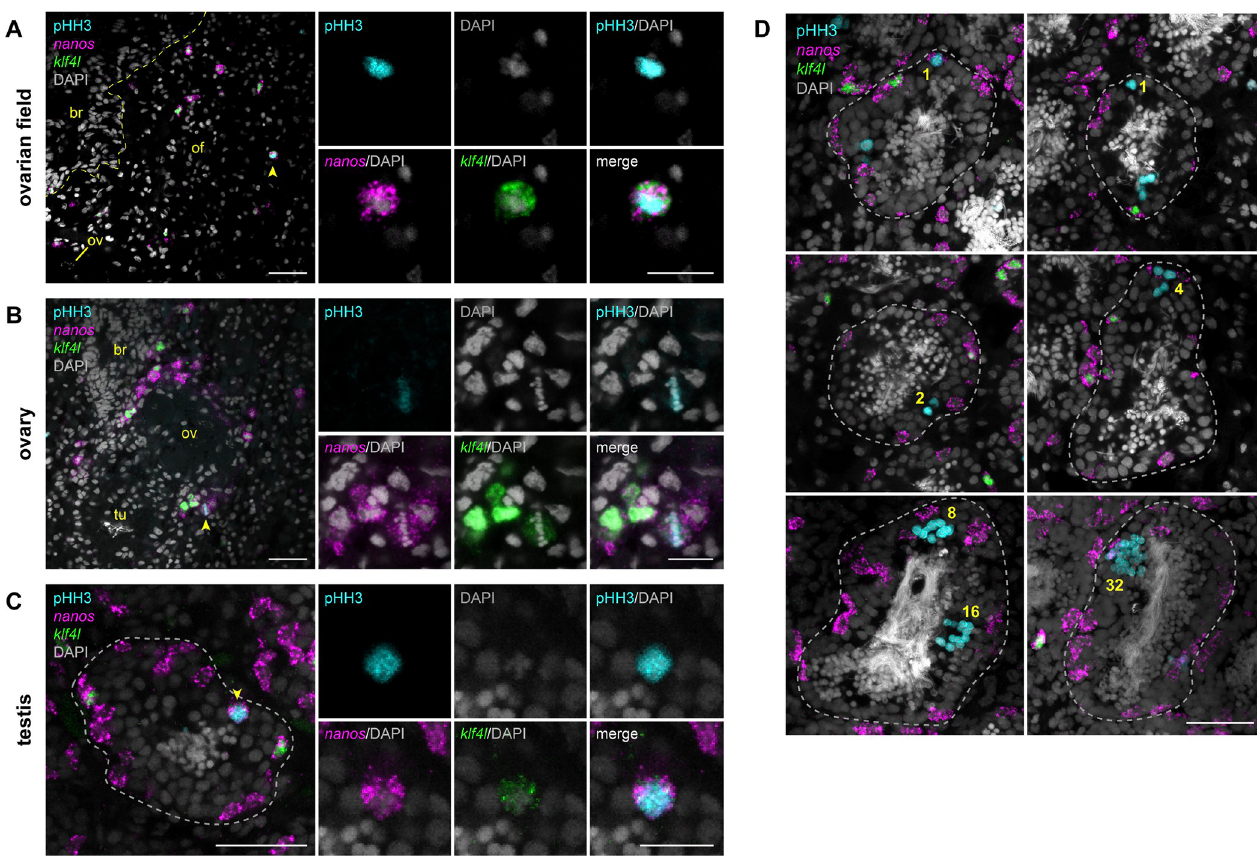
Fig 3. klf4l + germ cells in planarian ovaries and testes are mitotically active. ( A–C ) Confocal sections showing dFISH of klf4l (green) and nanos (magenta) and immunostaining of mitotic marker pHH3 (cyan) in the ovarian field (of) located anterior to the ovary (ov) and proximal to the brain (br; boundary denoted by yellow dashed line) ( A ), the ovary, which is anterior to the tuba (tu) ( B ), and the testis (boundary denoted by gray dashed line) ( C ). Side panels are high magnification views of klf4l / nanos /pHH3 triple-positive cells (yellow arrowheads). ( D ) Confocal sections (top 4 panels) and maximum intensity projections (bottom 2 panels) showing dFISH of klf4l (green) and nanos (magenta) and immunostaining of pHH3 (cyan) in testes (boundary denoted by gray dashed line). Yellow numbers denote pHH3 + germ cells dividing throughout spermatogenesis: single nanos + cell; single nanos − cell; 2-, 4-, 8-cell spermatogonial cysts; and 16- and 32-cell spermatocyte cysts. ( A–D ) Nuclei are counterstained with DAPI (gray). Scale bars, 50 μ m for whole-gonad images, 20 μ m for side panels. klf4l , klf4-like ; pHH3, phospho-Histone H3.